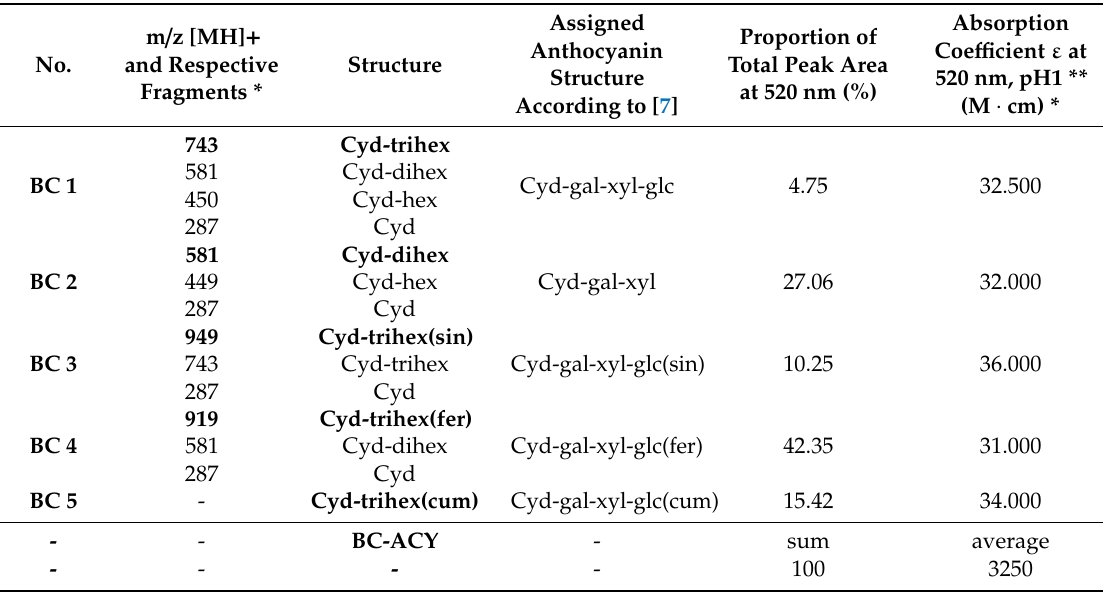
Table A2. Major anthocyanin structures characterized by mass spectrometry in the complex anthocyanin extract of black